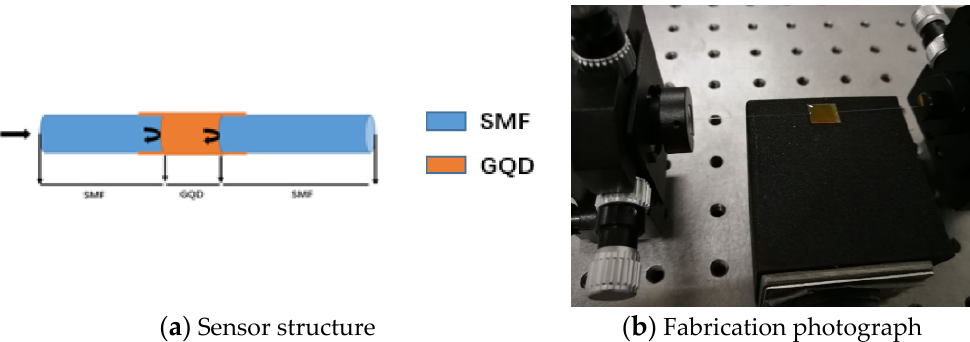
Figure 1. Optical fiber humidity sensor.